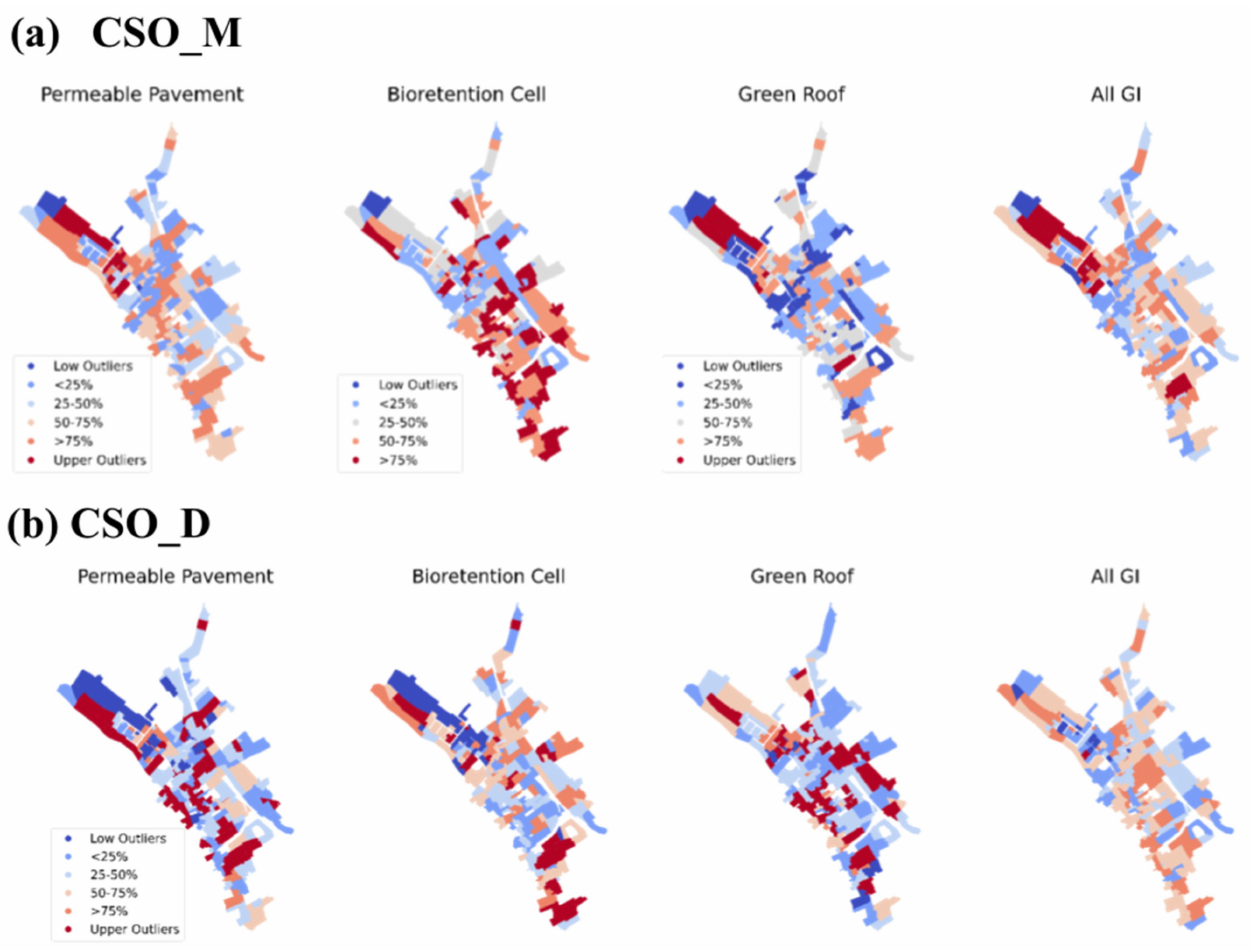
Figure 7. Box map for the sensitivity to location of GI impact on resilience enhancement. Level of service loss measured: CSO. ( a ) CSO magnitude (CSO_M). ( b ) CSO duration